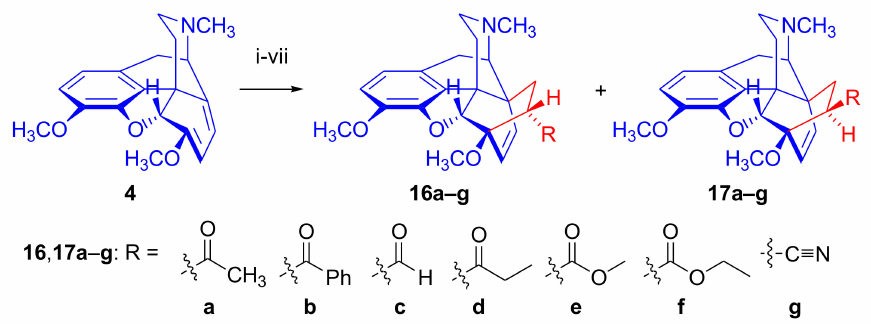
Figure 6. Reaction of thebaine with unsymmetric dienophiles. Reagents and conditions : (i): 11.5 equiv. methyl vinyl ketone, reflux, 1 h, 93% (7 α ) and 0.5% (7 β ); (ii): 1 equiv. phenyl vinyl ketone, benzene, reflux, 2 h, 70% (7 α ); (iii): (A): 14 equiv. acrolein, neat, reflux, 1 h, >85%, or (B): 1.8 equiv. acrolein, benzene, 65–70 ◦ C, 4 h, 57%; (iv): 3.7 equiv. ethyl vinyl ketone, neat, 100 ◦ C, 4 h, 80%; (v): 17 equiv. methyl acrylate, reflux, 6 h; (vi): 4.88 equiv. ethyl acrylate, neat, reflux, 6 h, 94% (7 α ) and 6% (7 β ); and (vii): 16.4 equiv. acrylonitrile, neat, reflux, 3 h, ca. 1:1 mixture of 7 α /7 β